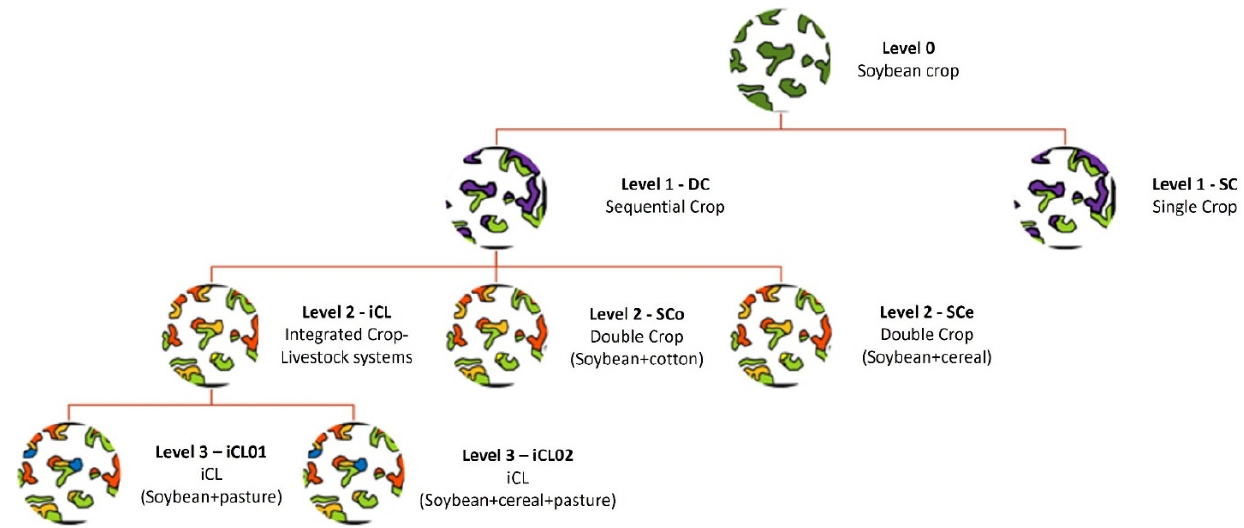
Figure 5. Hierarchical classification: the four classification levels and the associated cropping systems classes.